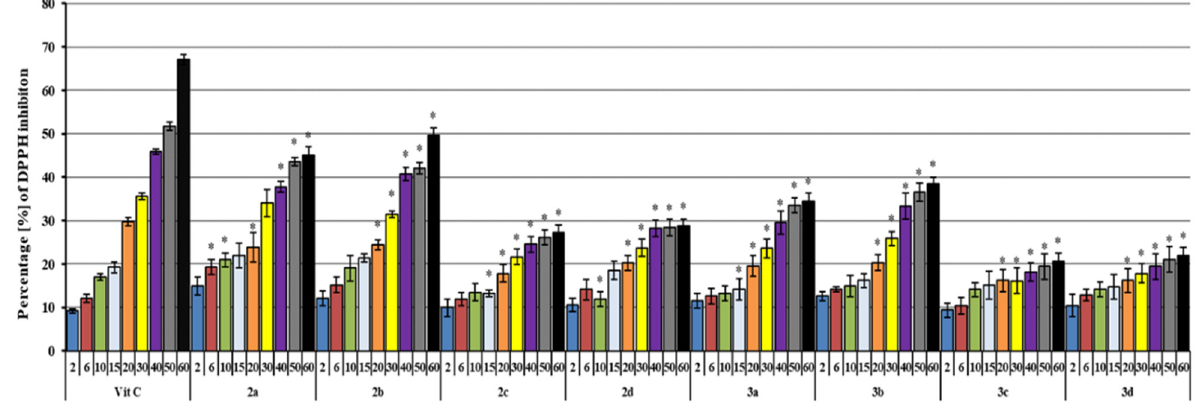
Figure 7. Effect of the analyzed ruthenium complex compounds on DPPH free radical scavenging. All tested compounds were used at concentrations 2–60 µmol/L. The DPPH radical scavenging activity of Trolox was used as a reference. Results are presented as a percentage of DPPH radical scavenger. The results represent mean ± SD of data from three individual experiments, each done at least four times; * p < 0.05 versus vitamin C.